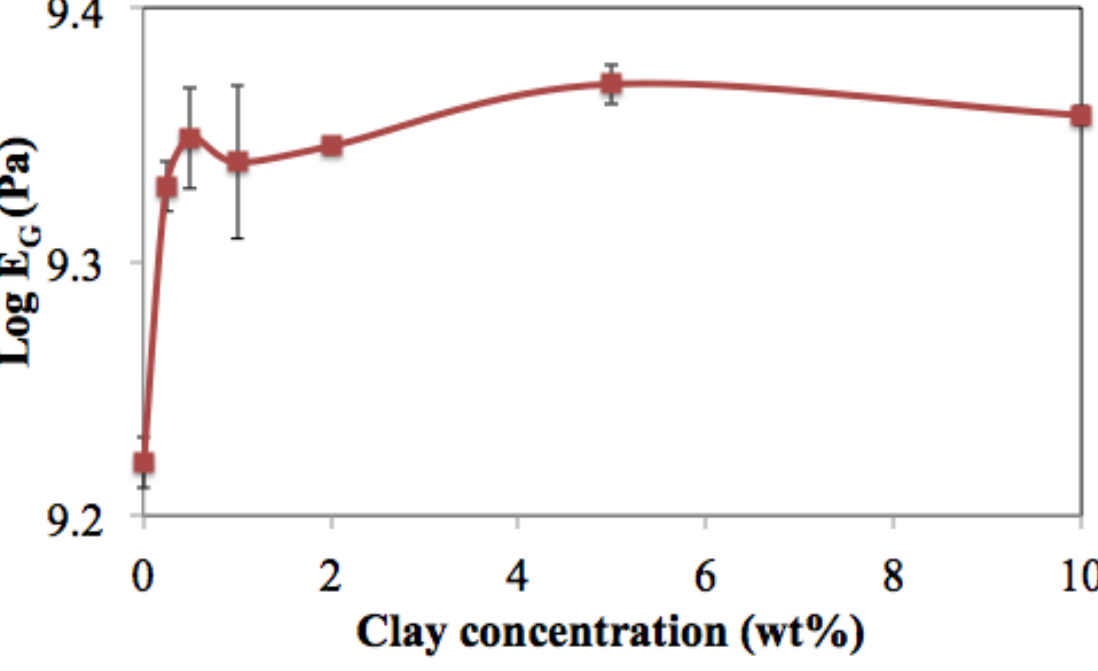
Figure 5. The glassy region storage modulus of the nanocomposites at − 90 °C as a function of clay concentration. Showing a slight decrease in E G at 10 wt.% clay due in part to clay agglomeration and poor dispersion.